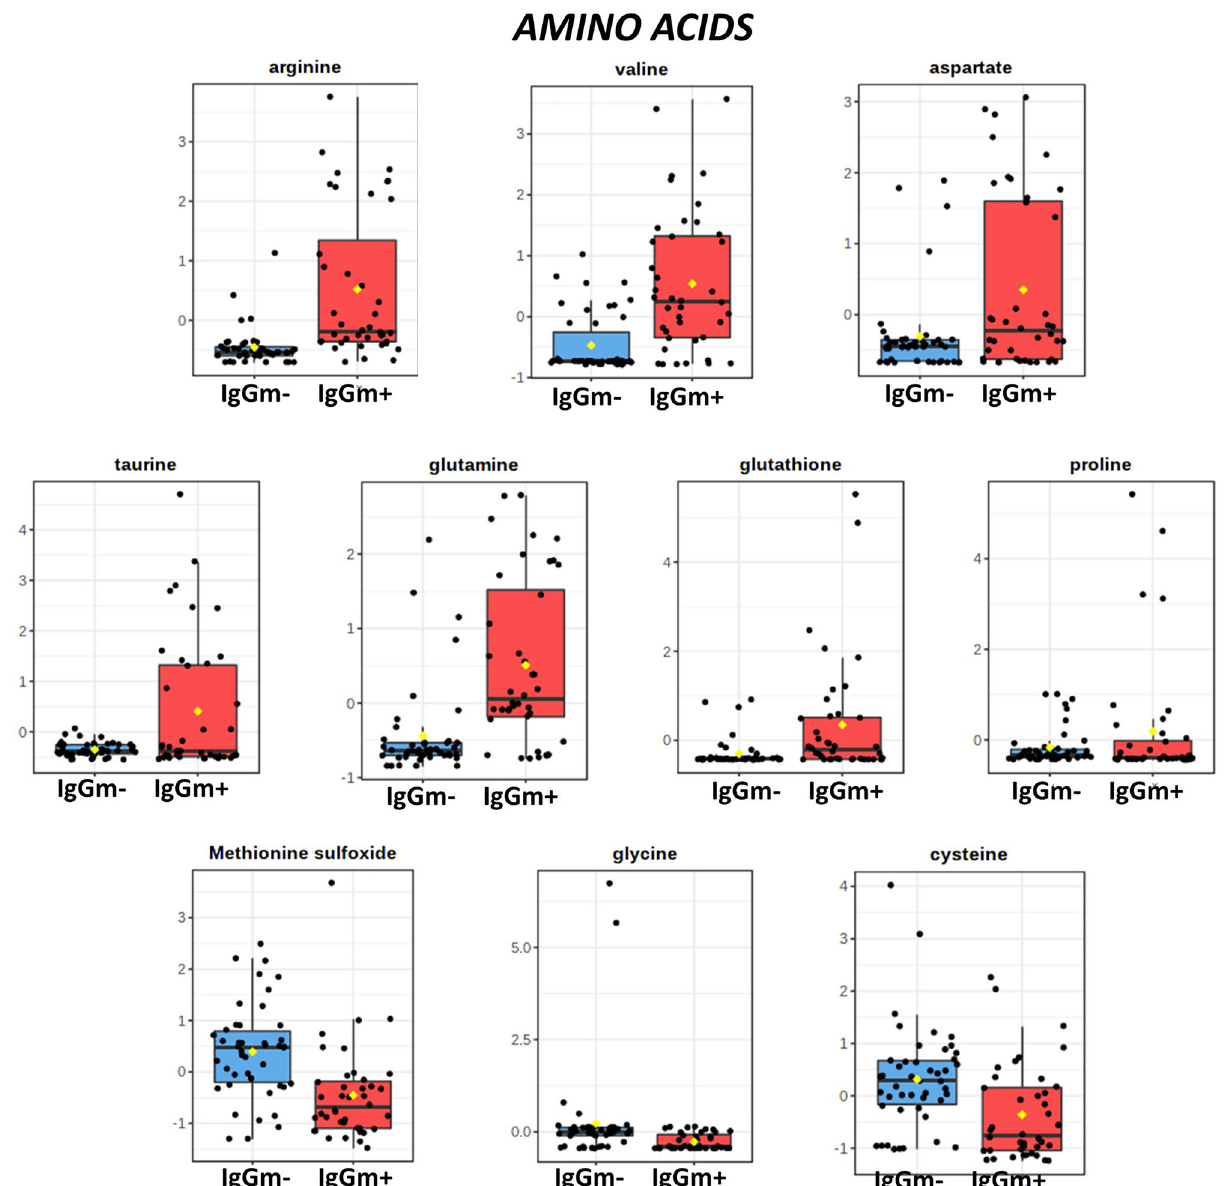
Figure 3. Amino acid levels in PBMC samples. Bar plots show the mean and standard deviation (SD) of the normalized peak